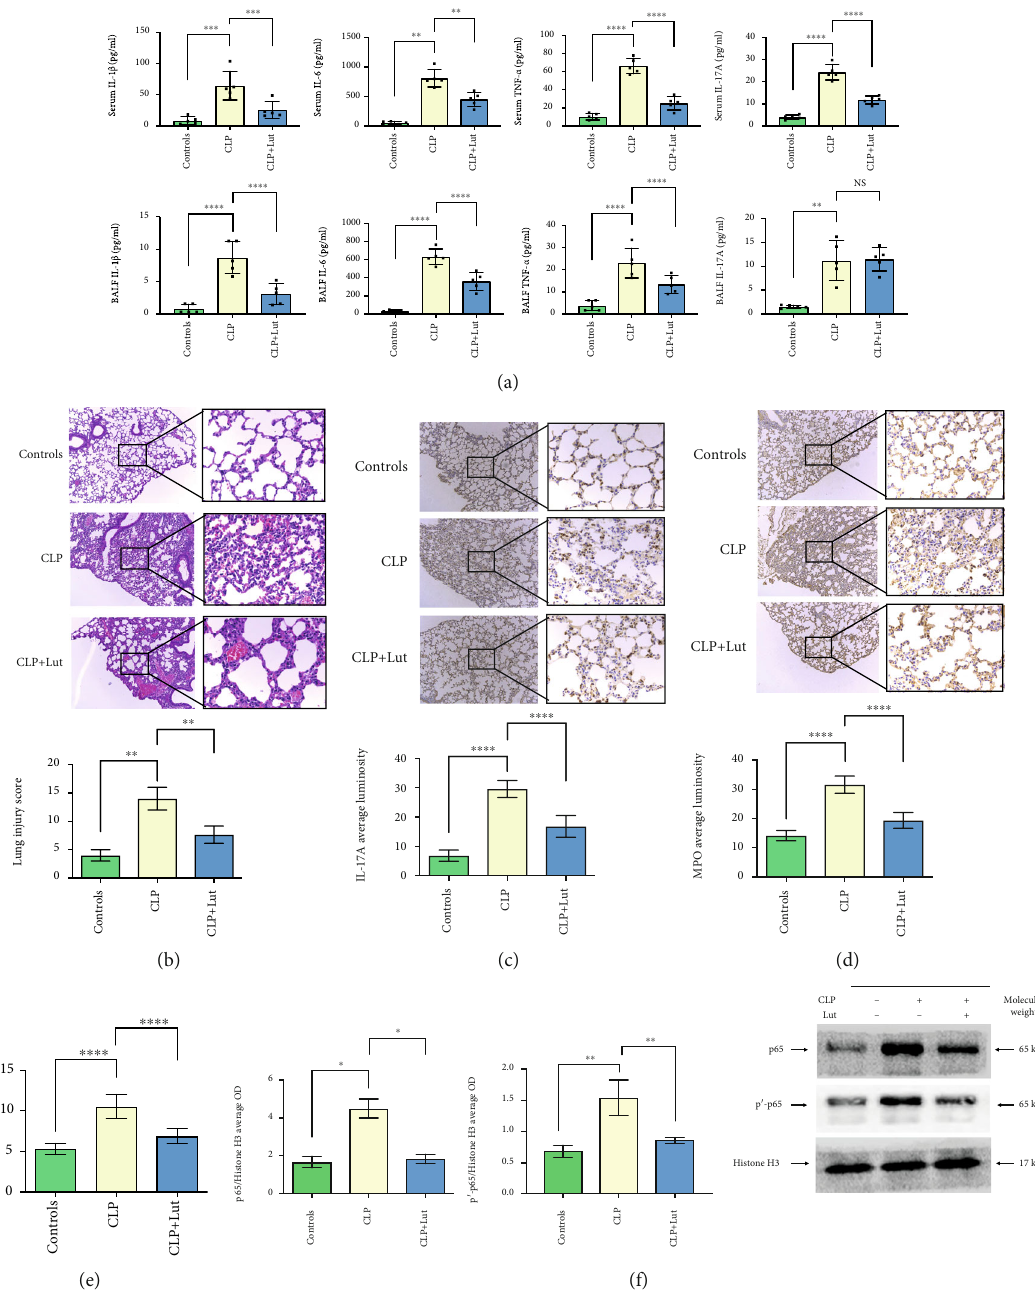
Figure 1: Treatment with luteolin reduces the severity of ALI. (a) Treatment with luteolin reduces the production of IL-1 β , IL-6, IL-17A, and TNF- α in serum and BALF of CLP mice, thereby playing an anti-in fl ammatory role. IL-1 β , IL-6, IL-17A, and TNF- α levels in serum and BALF of mice were measured using a mouse cytokine/chemokine magnetic bead panel kit. (b) Luteolin treatment alleviates lung injury in CLP-induced ALI mice. Lungs from each experimental group were stained with H&E and processed for histological examination. CLP-induced ALI mice exhibited obvious lung injury. The CLP+Lut group exhibited a signi fi cant reduction in the thickness of the alveolar wall, alveolar hemorrhage and collapse, and in fl ammatory cell in fi ltration relative to the CLP group. Lung injury in the CLP+Lut group was milder than that in the CLP group. (c, d) Luteolin reduced the proportion of MPO producing neutrophils and IL-17A protein levels in the lungs of CLP mice, thereby playing a protective role in ALI. Immunohistochemical staining for MPO and IL-17A was performed on para ffi n-embedded, formalin- fi xed lung tissue slices as described in Materials and Methods. (e) Luteolin alleviates pulmonary edema in the CLP-induced mouse model. Pulmonary edema was measured by the lung W / D weight ratio. (f) Luteolin reduced the nuclear translocation of NF- κ B (p65) and NF- κ B (p65) phosphorylation activation in lungs of CLP mice. p65 protein levels were measured by western blotting. Each group n = 5 , experiments are repeatable, and the most representative one was shown. Data of the column graphs are presented as means ± SD . NS: not signi fi cant. ∗ p < 0 : 05 , ∗∗ p < 0 : 01 , ∗∗∗ p < 0 : 001 , and ∗∗∗∗ p < 0 : 0001 by the one-way ANOVA followed by LSD multiple comparison test, compared between the control, CLP, and CLP+Lut